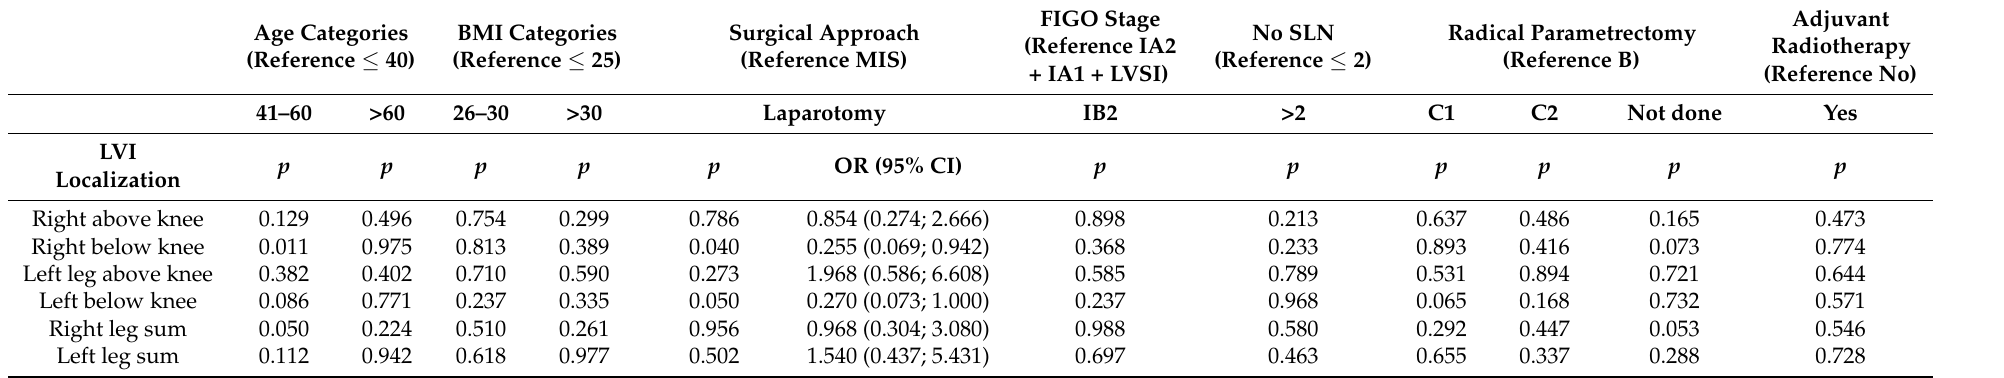
Table 3. Risk factors analysis associated with objective LLL at 24 months